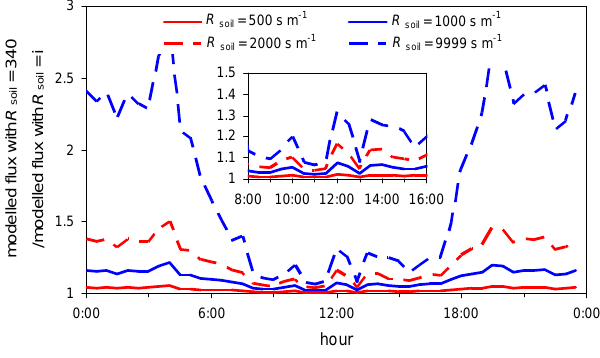
Figure 10: Half hourly median of the response of the modelled NO 2 deposition flux to the soil 2 Fig. 10. Half-hourly median of the response of the modelled = 500sm − 1 NO 2 deposition flux to the soil resistance for R NO 2 resistance for 2 NO R = 500 s m -1 (solid red line), 2 NO R = 1000 s m -1 (solid blue line), 2 NO R = 3 soil soil soil soil = = 1000s m − 1 (solid blue line), R NO 2 (solid red line), R NO 2 2000 s m -1 (dotted red line), and = 9999 s m -1 (dotted blue line) from 29 August to 20 4 soil soil = 9999sm − 1 (dotted blue 2000sm − 1 (dotted red line), and R NO 2 September 2005. The reference NO 2 flux was modelled using = 340 s m -1 . 5 soil line) from 29 August to 20 September 2005. The reference NO 2 = 340sm − 1 flux was modelled using R NO 2 soil